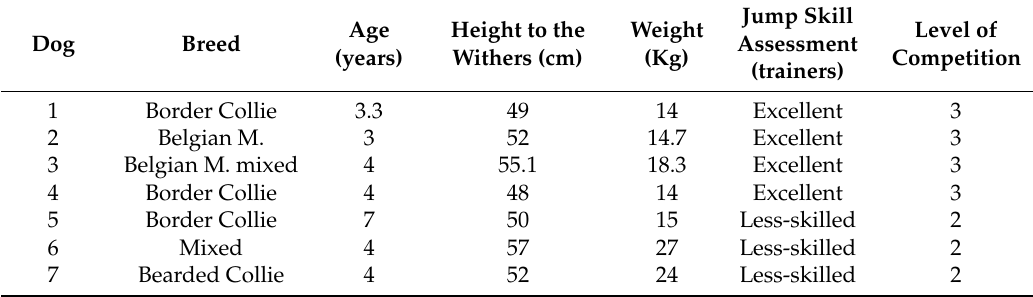
Table 1. Details of agility dogs used in the study. Jump skill was assessed by two highly experienced agility